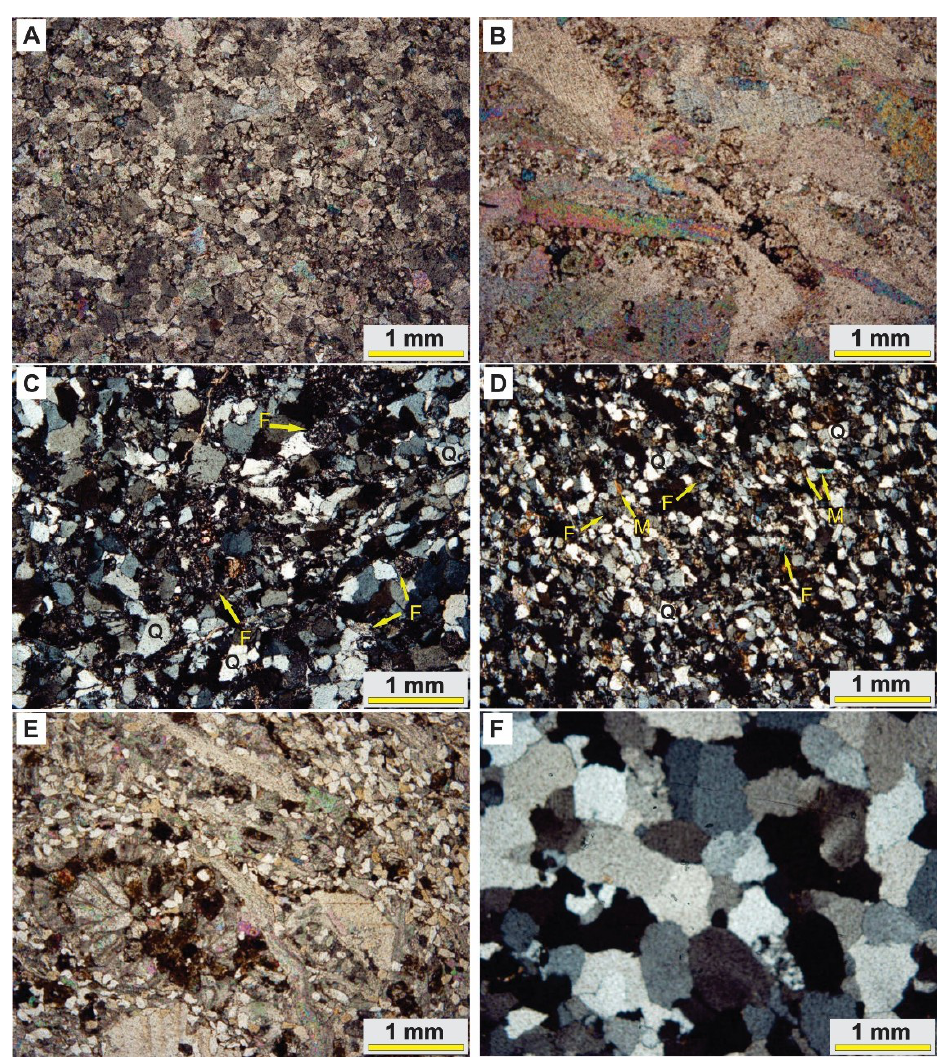
Figure 4. Photomicrographs of lithological units (rock thin sections under a petrographic microscope). ( A ) Soltanieh Formation showing high abundance of dolomite; ( B ) Deh-Sufyian limestone composed of calcite minerals and fossil shells; ( C ) arkosic sandstone of Lalun Formation composed of feldspars (F) and quartz (Q); ( D ) Jeirud Formation includes hybrid limestone with sandy quartz grains; ( E ) Deh-Molla Formations composed of quartz (Q) and feldspar (F) and few amounts of mica (M) with carbonates cement; and ( F ) quartz arenite sandstone of Fasham Formation mainly composed of quartz (Q).